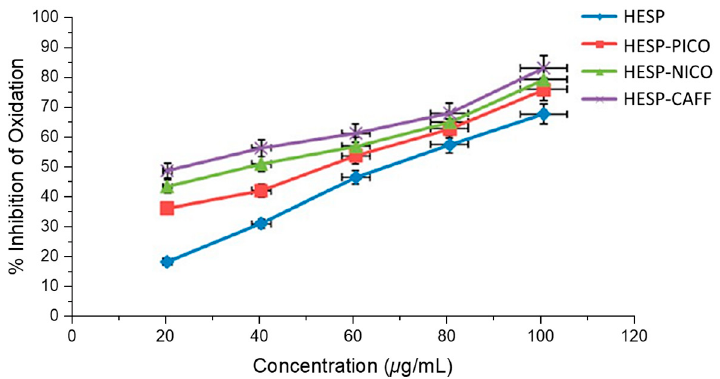
Figure 12. Percent inhibition of inflammation of HESP, HESP-PICO, HESP-NICO and HESP-CAFF. Adapted from [72] with permission. Copyright © 2017 American Chemical Society.